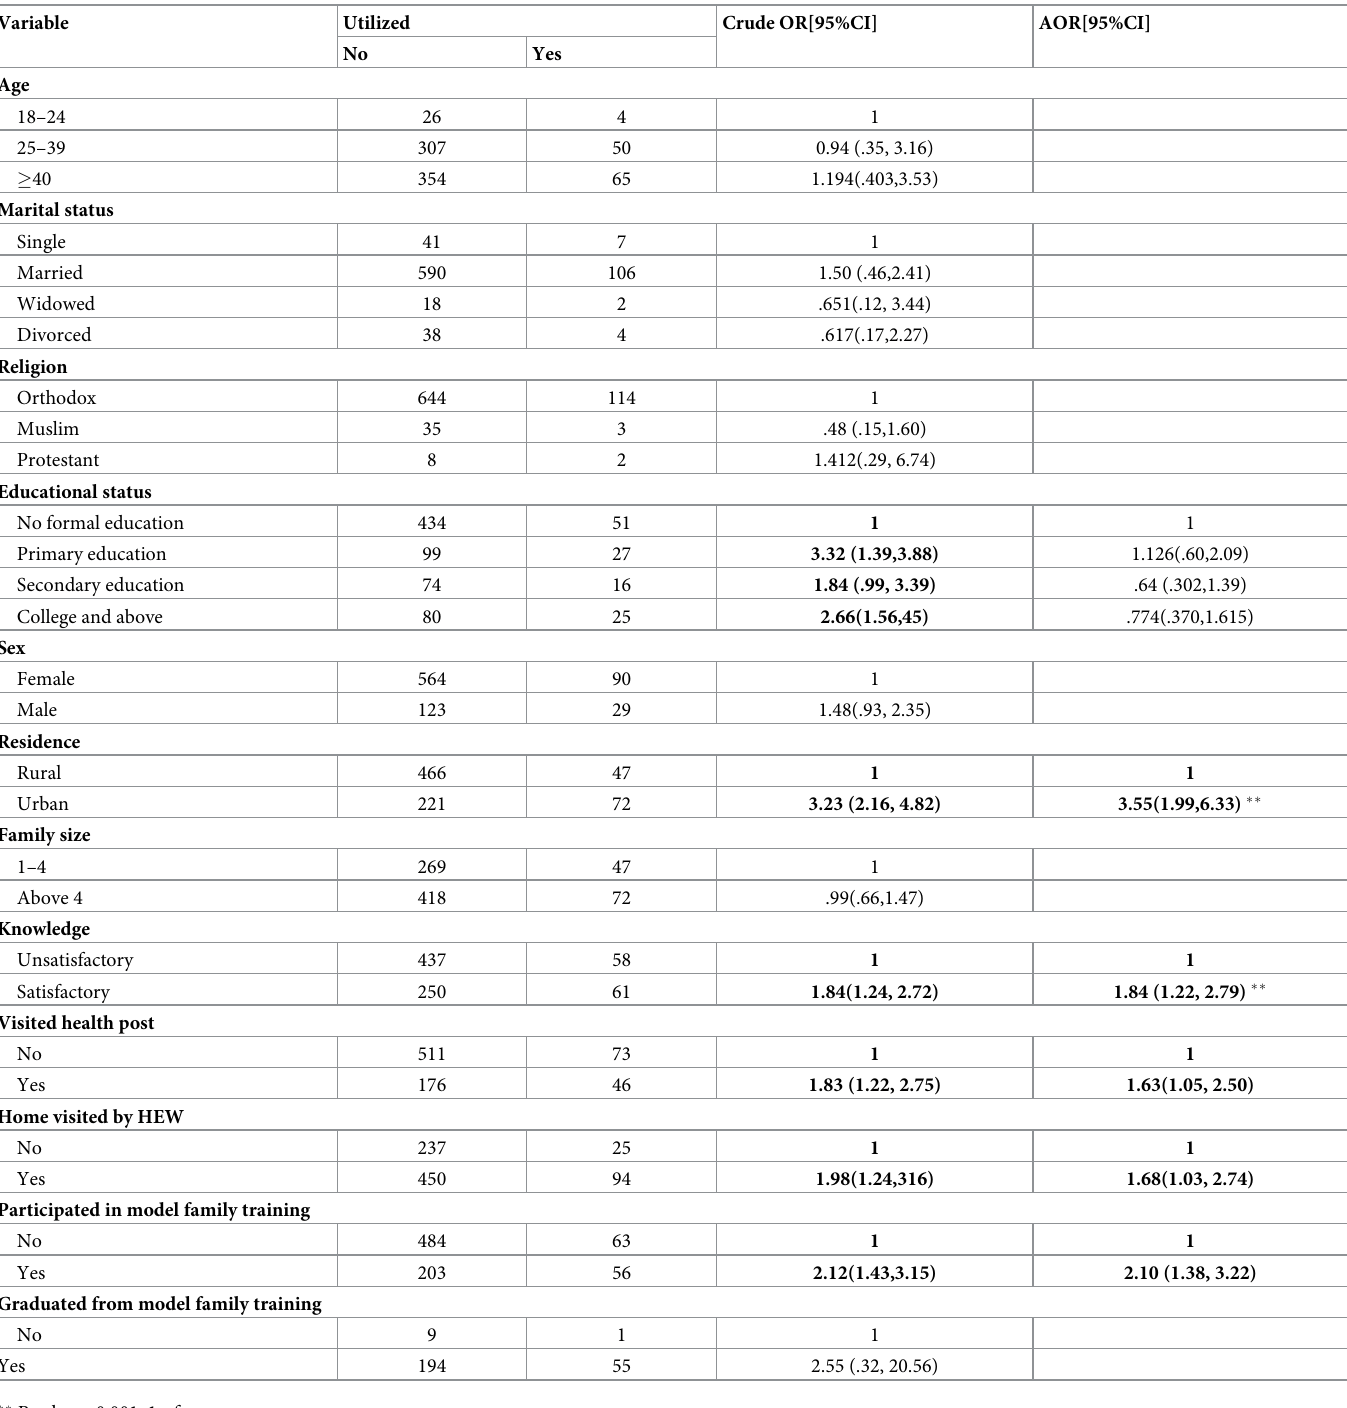
Table 4. Bivariable and multivariable analysis of factors associated with utilization of health extension package in East Gojjam Zone, Northwest Ethiopia,